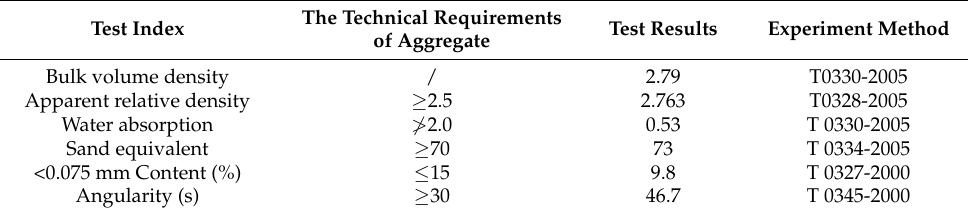
Table 5. Test results of various indicators of limestone fine